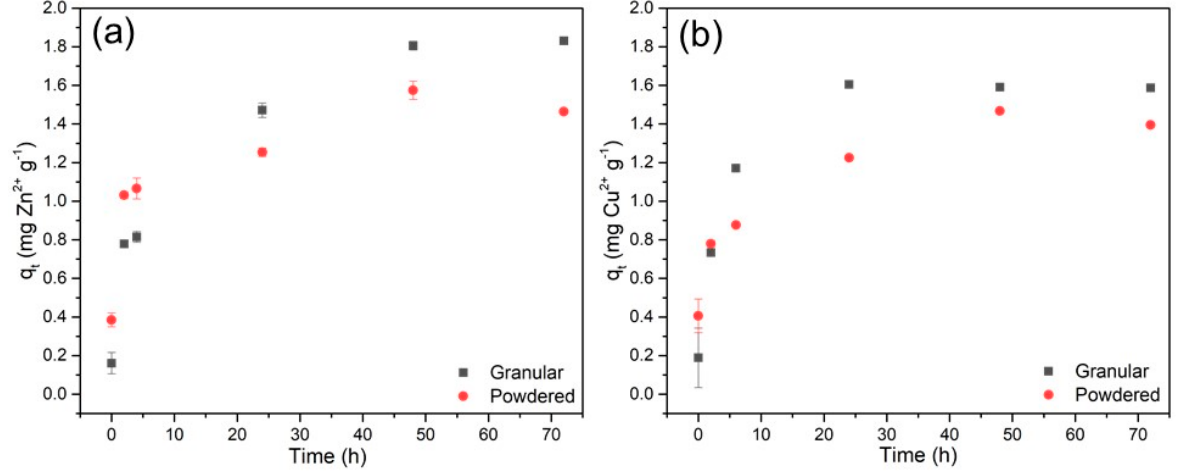
Figure 1. Adsorption curve of metallic ions by granular and powdered biomass: ( a ) Zn 2+ ; ( b ) Cu 2+ . The adsorption process presents phases associated with the steps of adsorption kinetics. It depends on the initial transport of metal ions from the aqueous solution to the outer surface of the BDA. The ions diffuse to the surface of the pores. Then, they are adsorbed on the active sites within the pores, reaching equilibrium. The quantification of metal ions adsorbed by the granular biomass was superior to that of the powdered BDA, contrary to expectations since the powdered biomass presented a greater external surface area. For zinc removal, granular biomass reached a final removal of 72.9% and powder- 58.3%. For copper, the removal for granular biomass was 91.8%, and for powder – 80.9%. The performance efficiency of the adsorbent depends on its selectivity and affinity for the